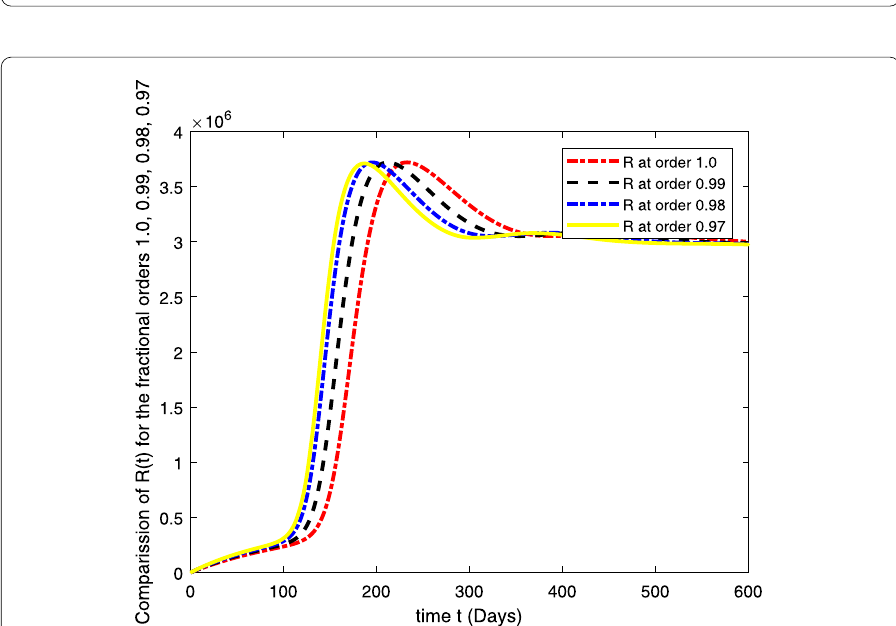
Figure 10 A comparative analysis of R ( t ) for the fractional orders 1.0, 0.99, 0.98,